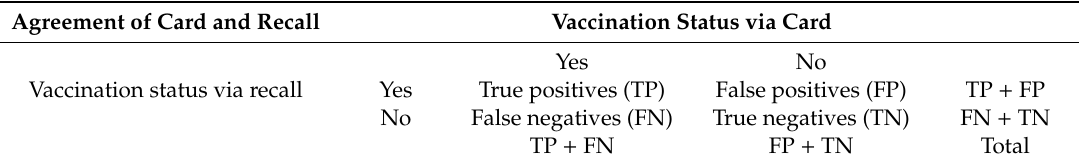
Table 1. 2 × 2 table used for accuracy